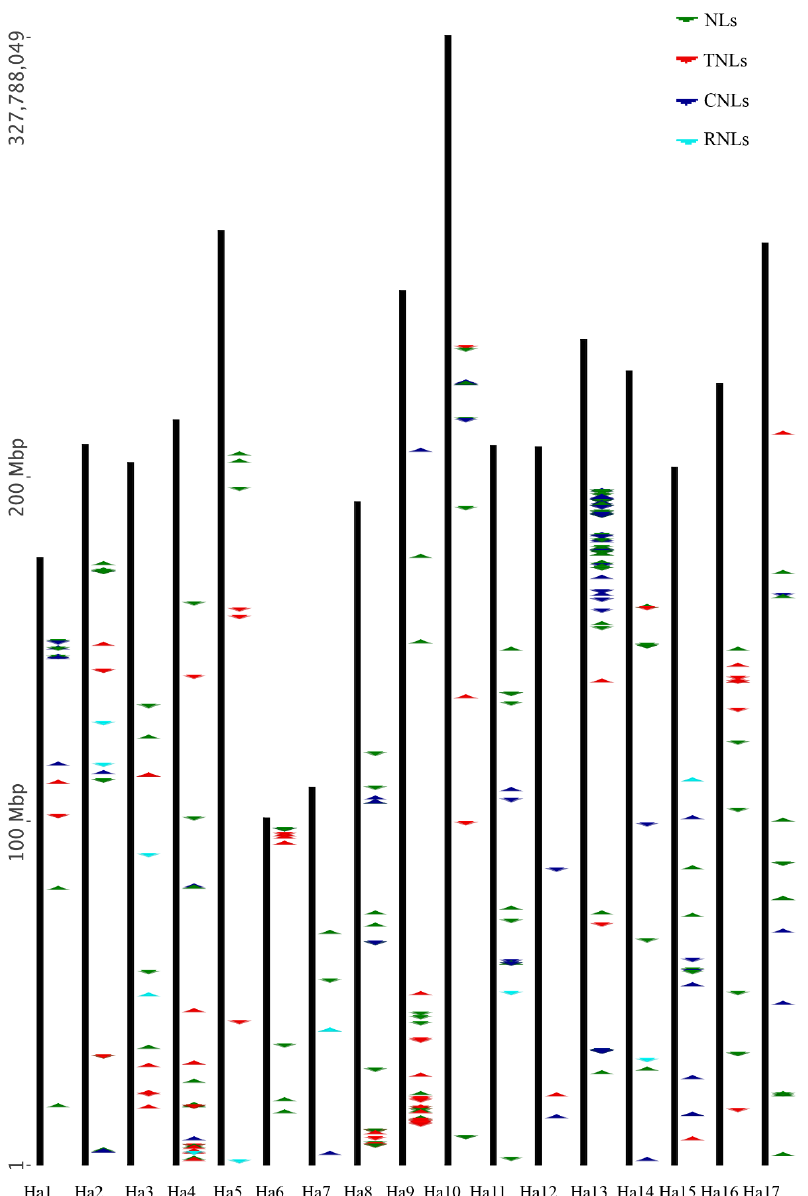
Figure 2. Chromosomal distribution of sunflower NBS gene clusters ( n = 17). Each arrow color represents an NBS gene type and orientation, and the thick vertical line represents a chromosome.